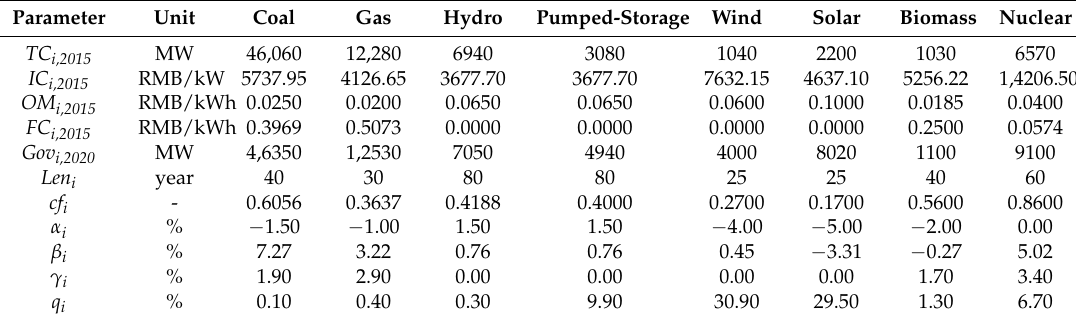
Table 4. Key economic and technical data for different generations of technology.